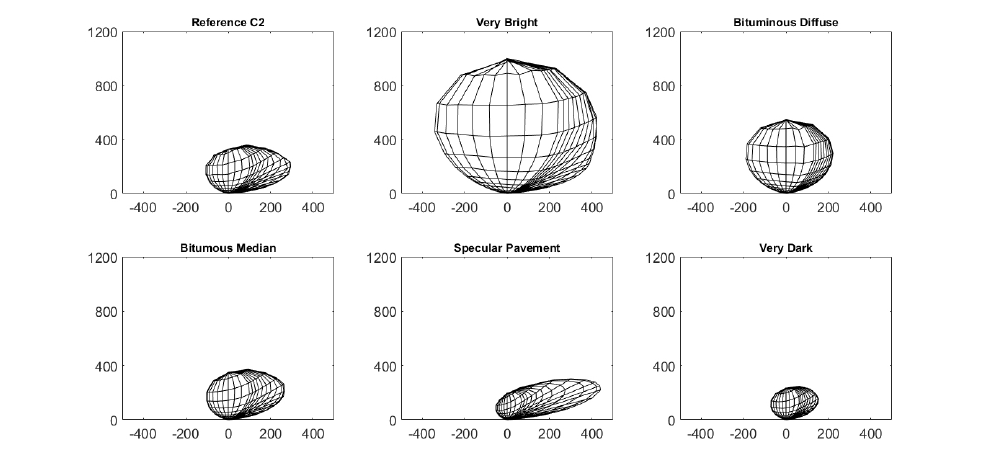
Figure 4. A 2D projection of r -table values of selected road surfaces of Table 2. The horizontal axis is 10 4 r sin γ cos β , while the vertical axis is 10 4 r cos γ